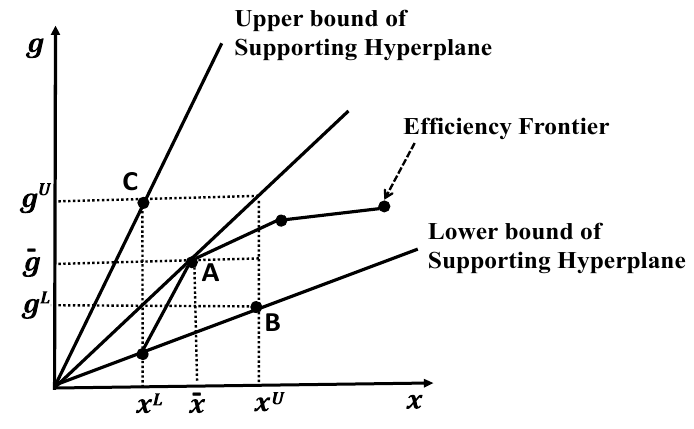
Figure 1. Range for supporting line on x and g.